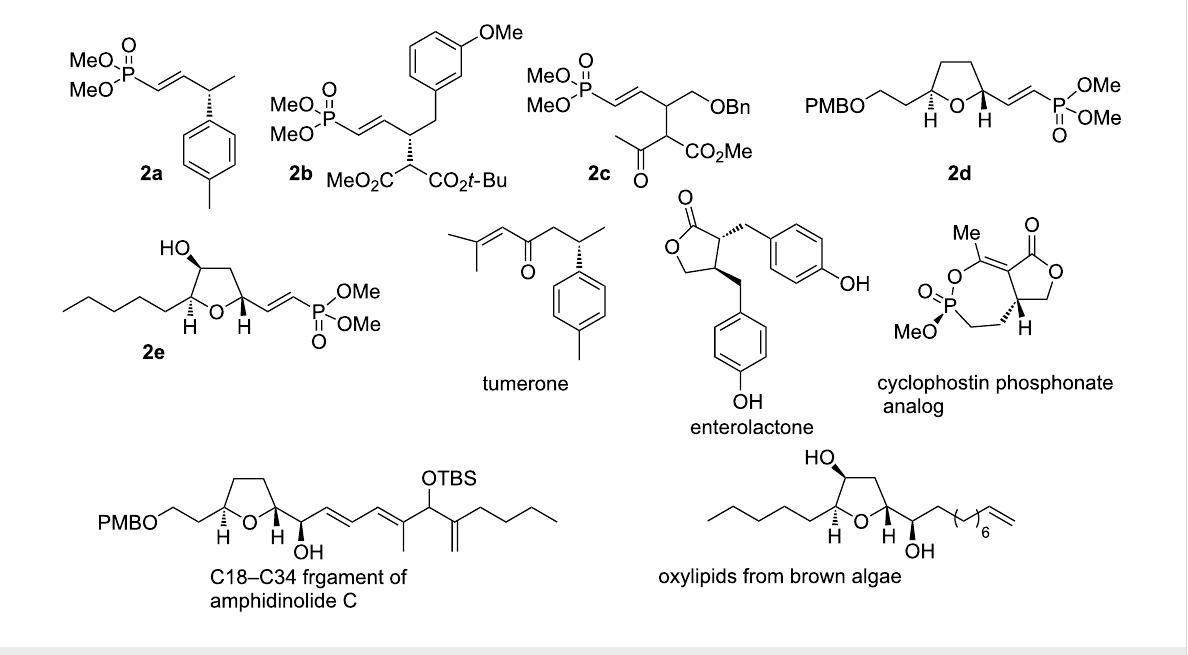
Figure 1: Natural products prepared using vinyl phosphonate intermediates.